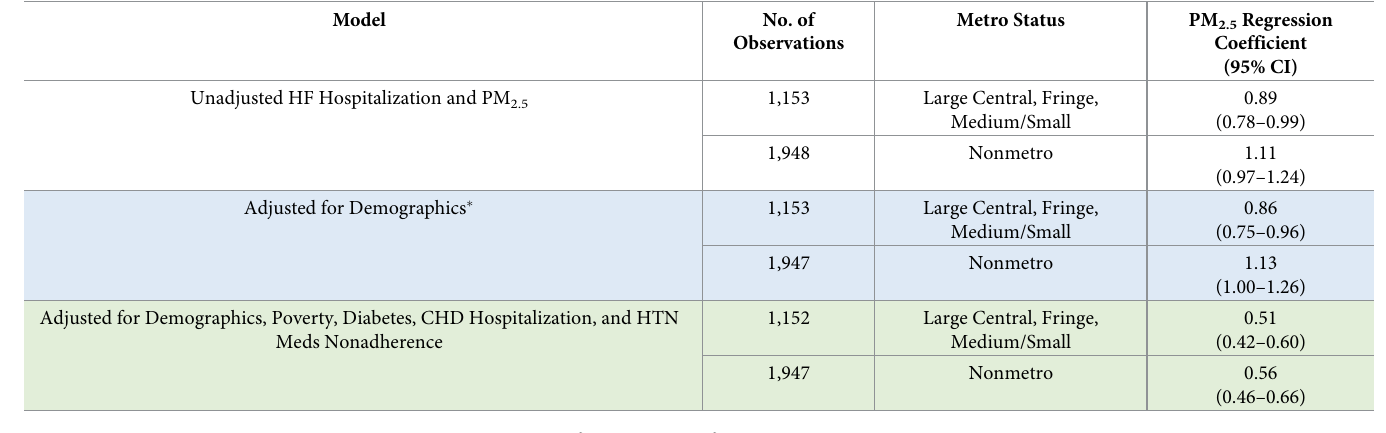
Table 5. HF hospitalizations subgroup analysis by metropolitan